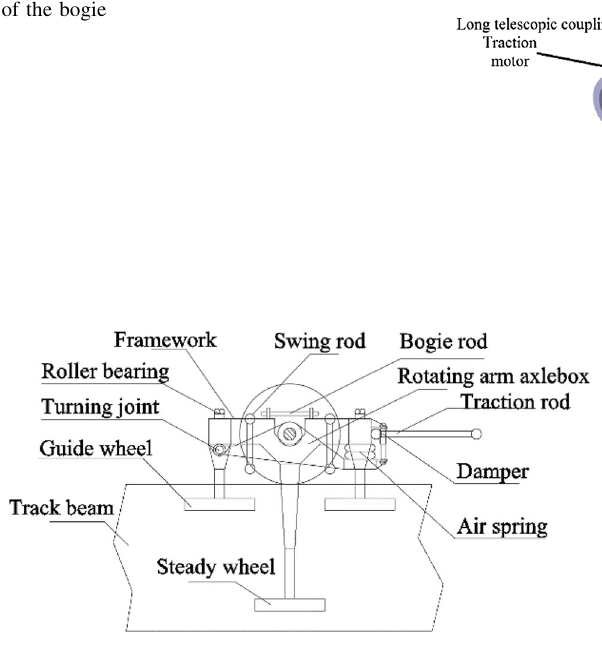
Fig. 5. Via the tumbler axle box structure, the longitudinal location and vertical load bearing of walking wheels are achieved. Meanwhile, vertical cushion and vibration